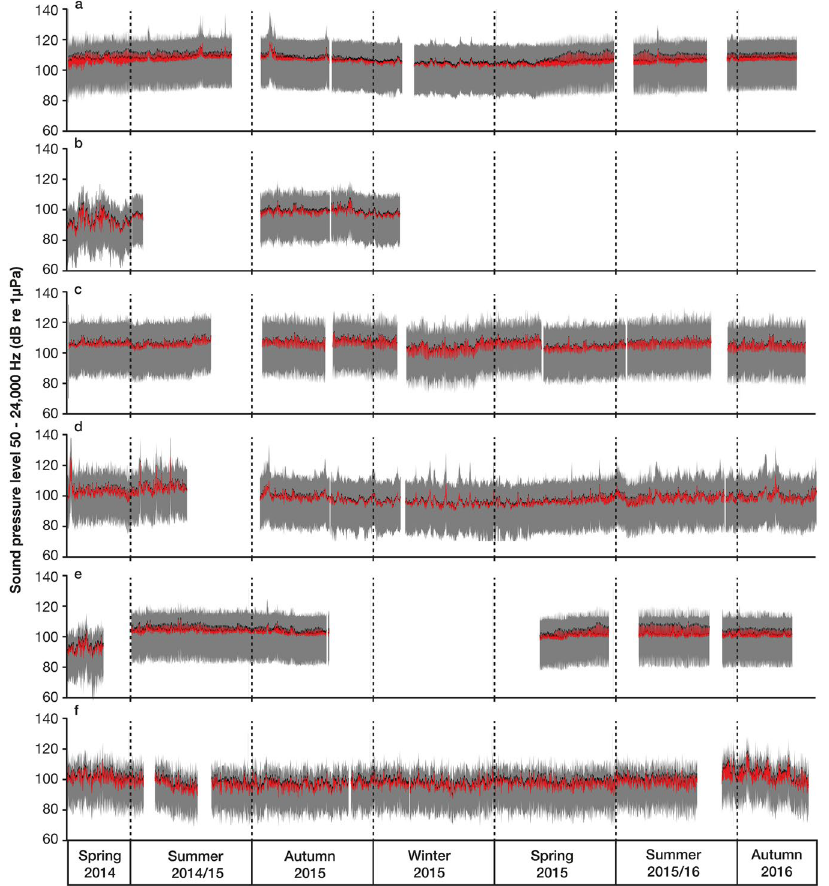
Figure 1. RMS level (red line), median (black line), 5 th and 95 th percentile (shaded area) of broadband sound pressure level between 50–24,000 Hz for daily (day, dawn, dusk and night) time categories over the duration of deployment for each of the six listening stations, ( a ) Horn Rock, ( b ) Waiheke Island, ( c ) Bean Rock, ( d ) Shearer Rock, ( e ) Flat Rock, and ( f ) Jellicoe